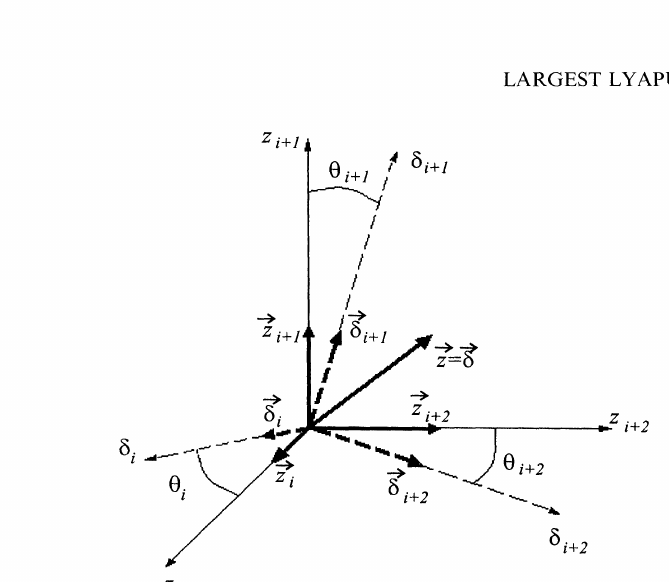
FIGURE 2 The spatial orientation of the system of coordi- nates associated with: (1) A-distance vector (dotted line), (2) state difference vector (continuous